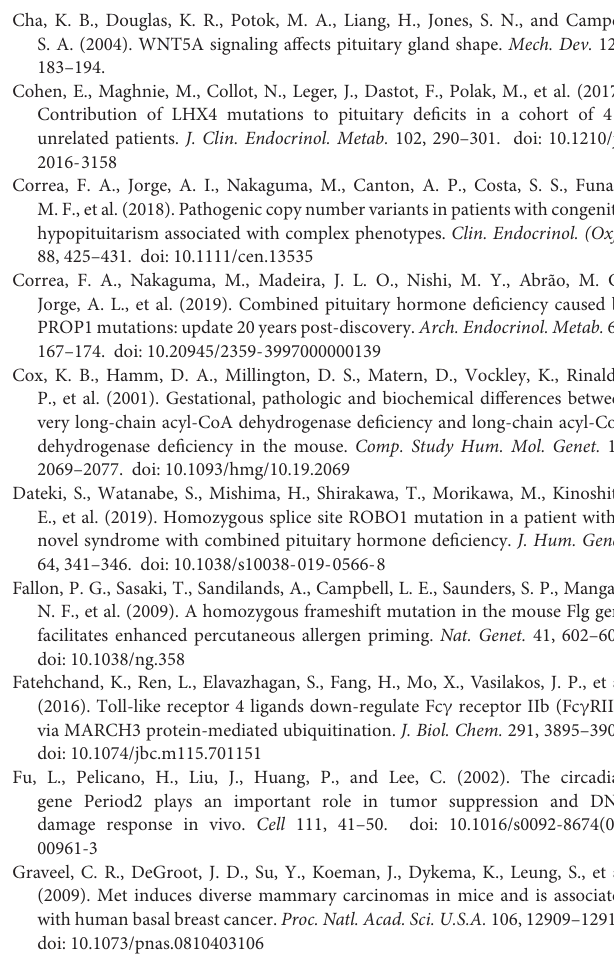
Supplementary Figure 1 | Diagram of study design. (A) Data analysis 1: rare, predicted-pathogenic variants were sought in 42 genes associated with pituitary gland development. (B) Data analysis 2: rare, predicted-pathogenic variants were sought in any gene in the genome (to capture undiscovered causes) that was inherited in a fashion that could explain the sporadic occurrence of the proband’s condition with a monogenic etiology ( de novo mutation, autosomal recessive, or X-linked recessive). HP, congenital hypopituitarism; NFSS, non-familial short stature. Supplementary Table 1 | Genetic variants found in 42 known pituitary-associated genes: ARID1B, ARNT2, BMP2, BMP4, CHD7, CDON, FGF8, FGF10,